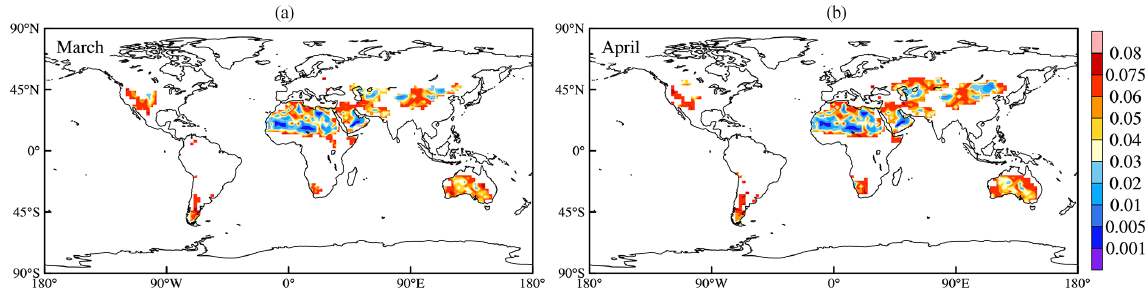
Figure 3. Monthly updated input data of global aerodynamic roughness length ( Z 0 ) (cm) in March (a) and April (b) . Data are derived from Prigent et al. (2005) and are re-gridded to 2 ◦ × 2.5 ◦ horizontal resolution in the model.